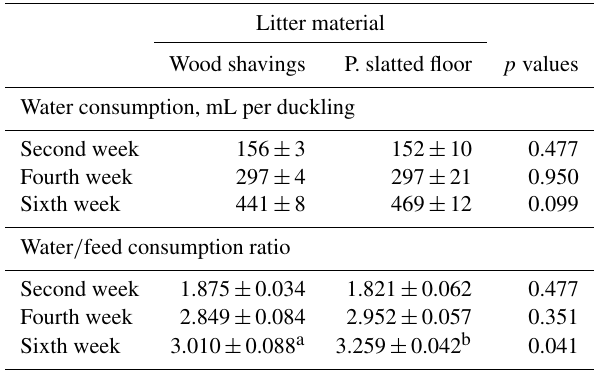
Table 4. The effects of PSF and WSs on water consumption wa- ter / feed consumption ratio (mean ±